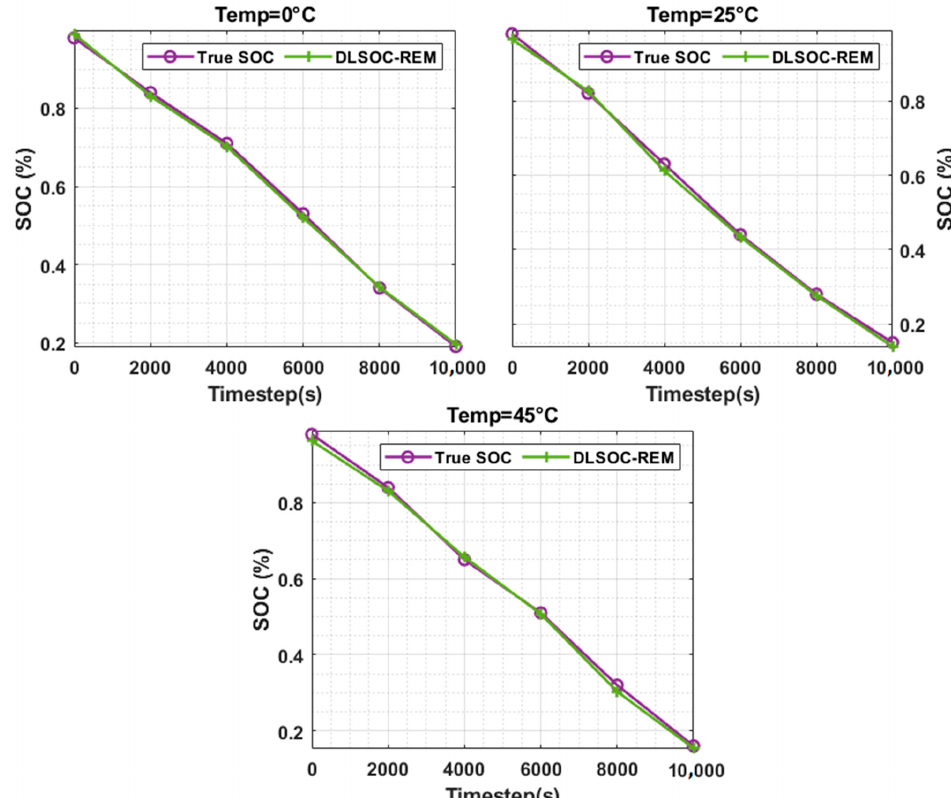
Figure 8. SOC analysis of DLSOC-REM technique on US06 drive cycle.